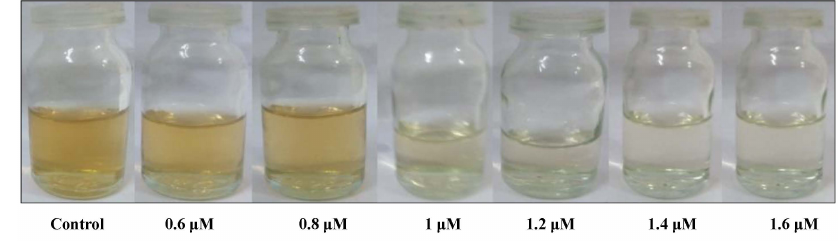
Figure 6. An in situ colorimetric assay for Hg +2 detection by the naked eye.